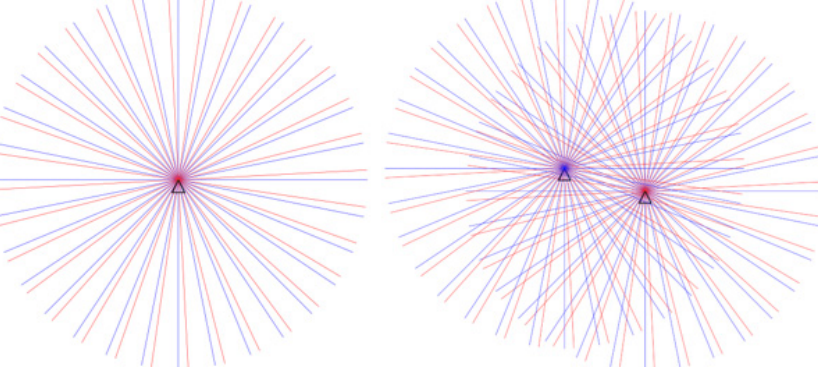
Figure 5. Effect of the de-correlation of radial measuring directions, and the minimisation of the effect through the use of two measuring stations with the crossover of their radial measuring direc- tions. The blue and red lines indicate different measurement directions in the same position but on different days.